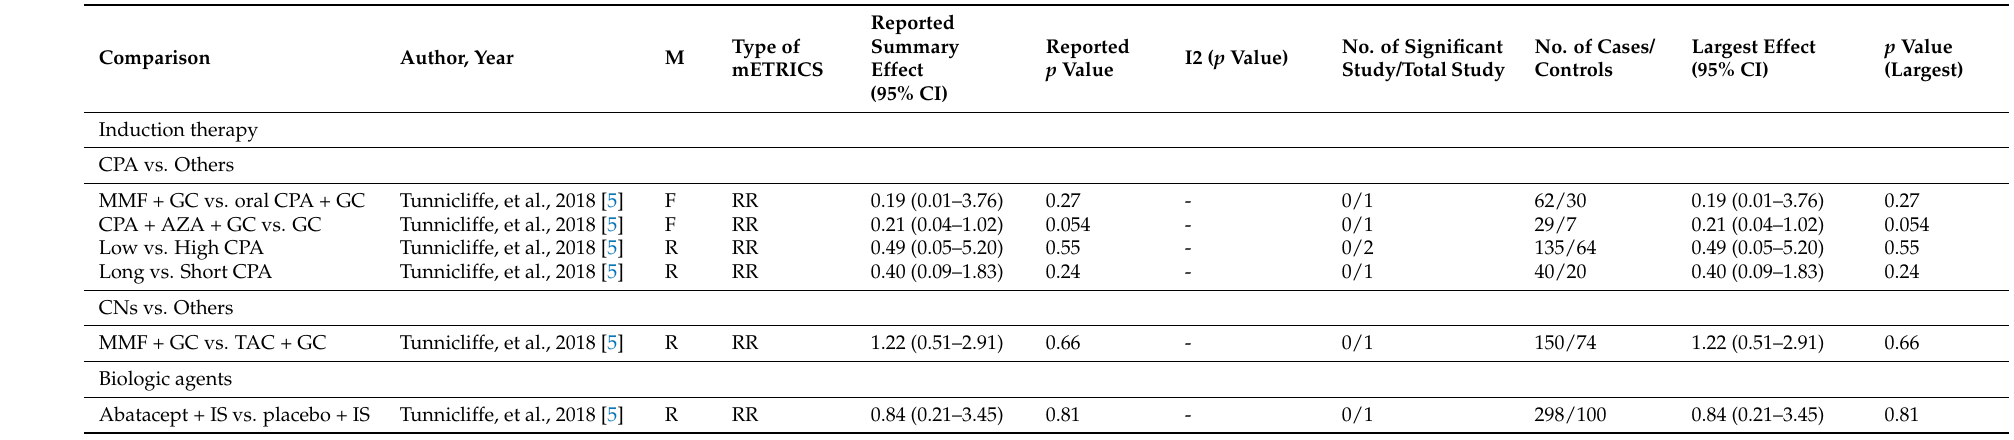
Table 9. Progression to ESRD during treatment of lupus